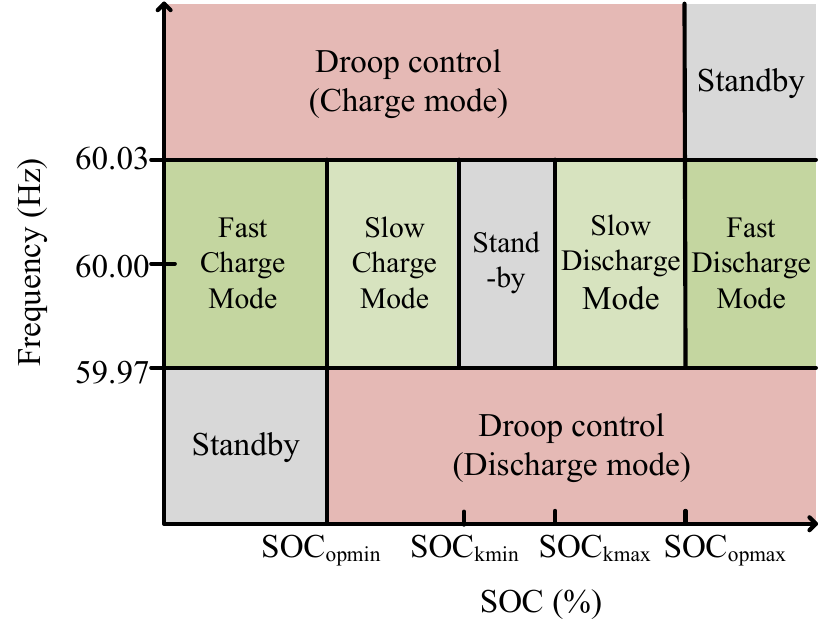
Figure 2. ESS operation mode by frequency and state of charge ( SOC ).